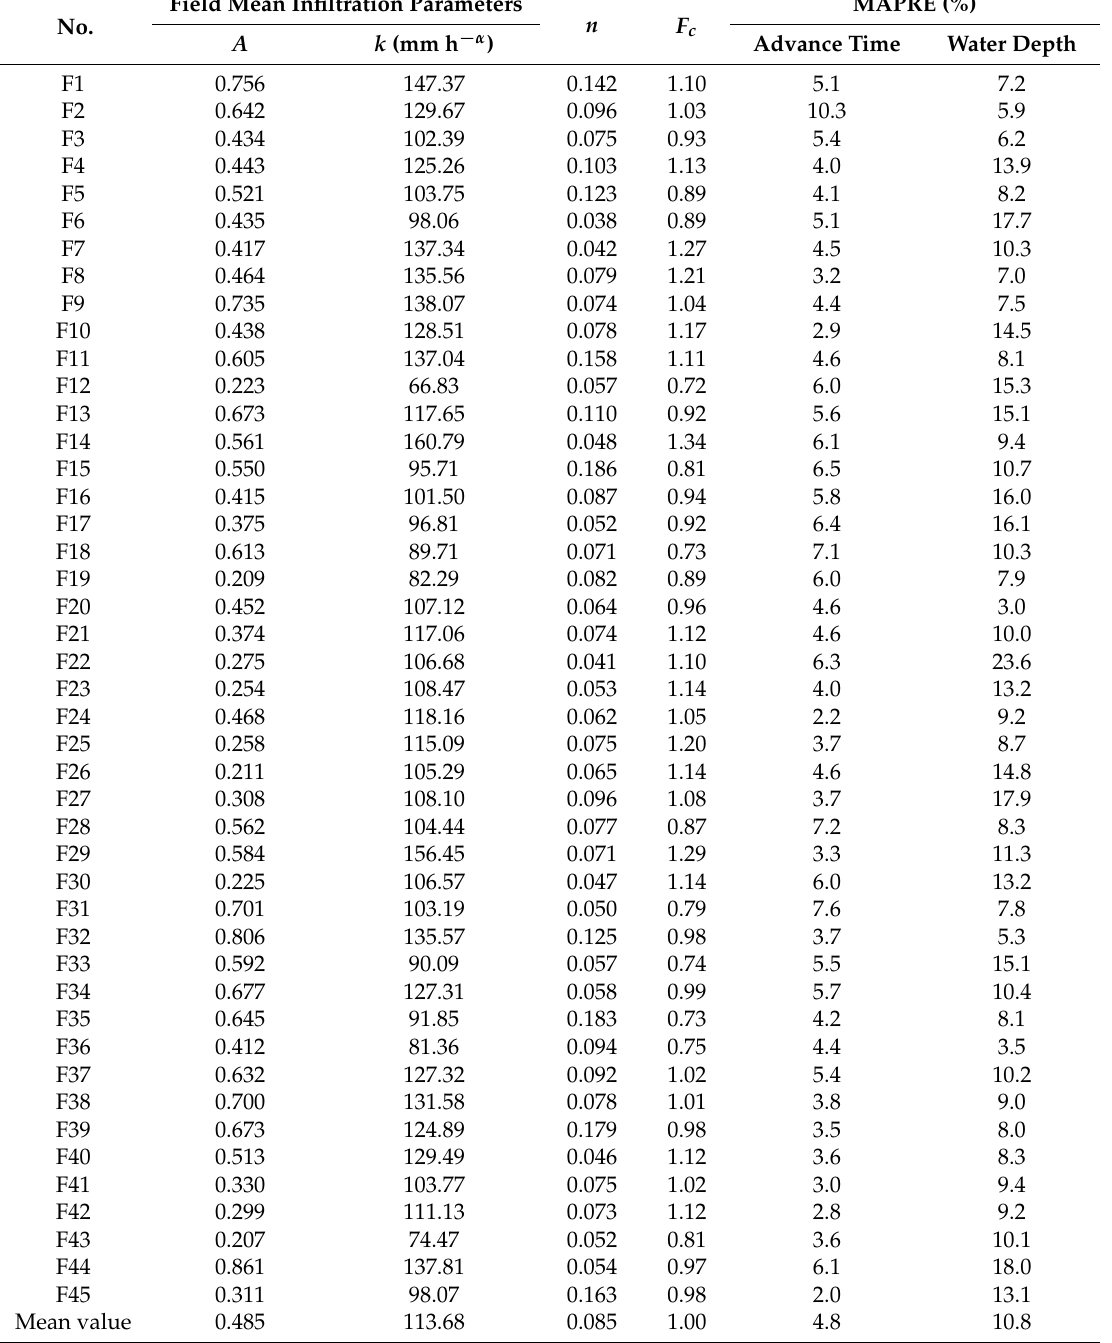
Table 2. Parameter estimation and error